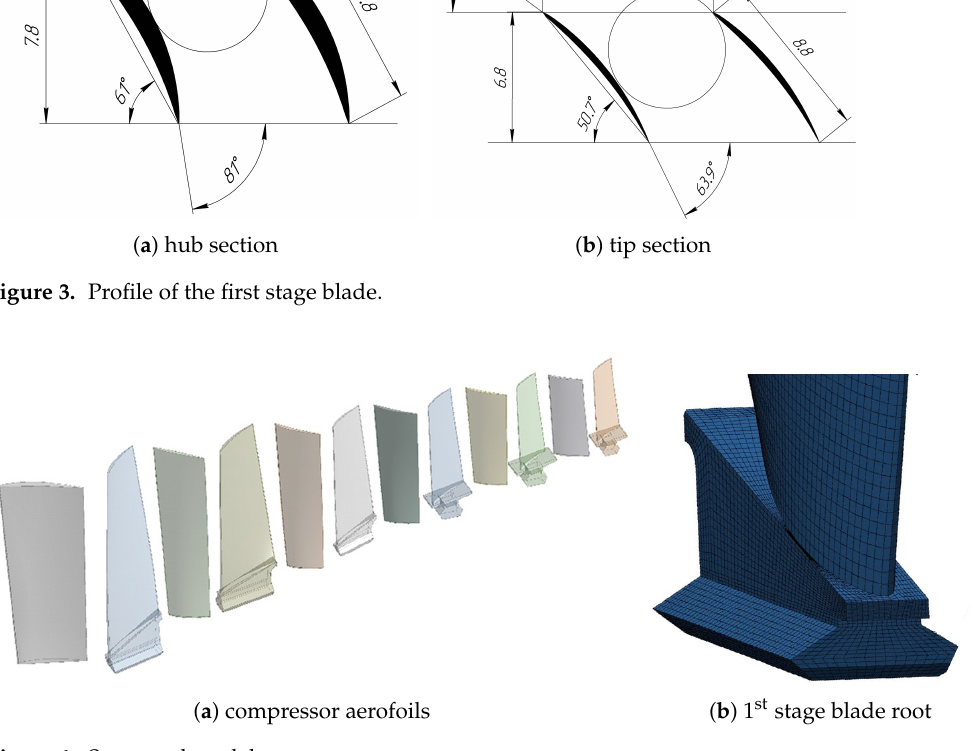
Figure 4. Structural model. Table 4. Number of compressor